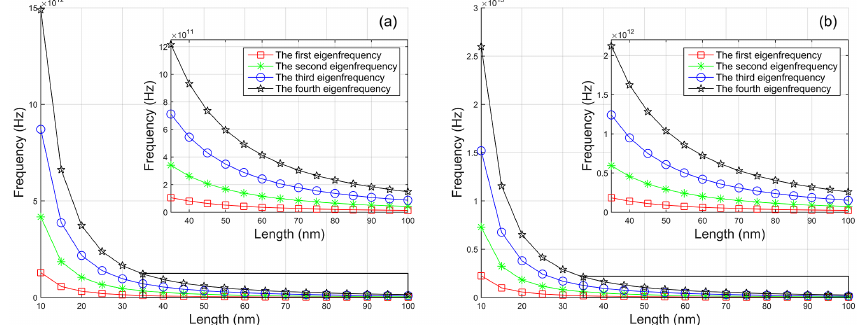
Figure 6. The first four eigenfrequencies of fixed–simply supported armchair nanotubes with nonlocal parameter µ = 0 . 04, (a) nanotube with chirality ( n , m ) = (10, 10) and diameter D = 1 . 356nm, (b) nanotube with and chirality ( n , m ) = (20, 20), diameter D = 2 . 712nm.